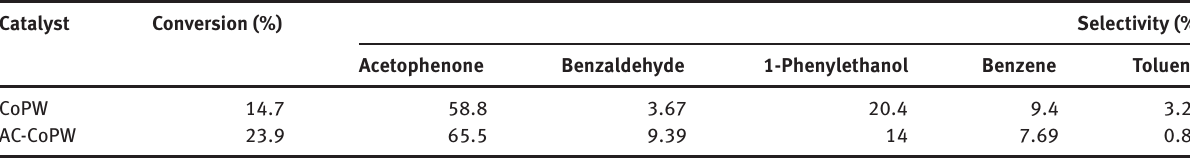
Table 3: Effect of activated carbon (AC) support on ethylbenzene oxidation.